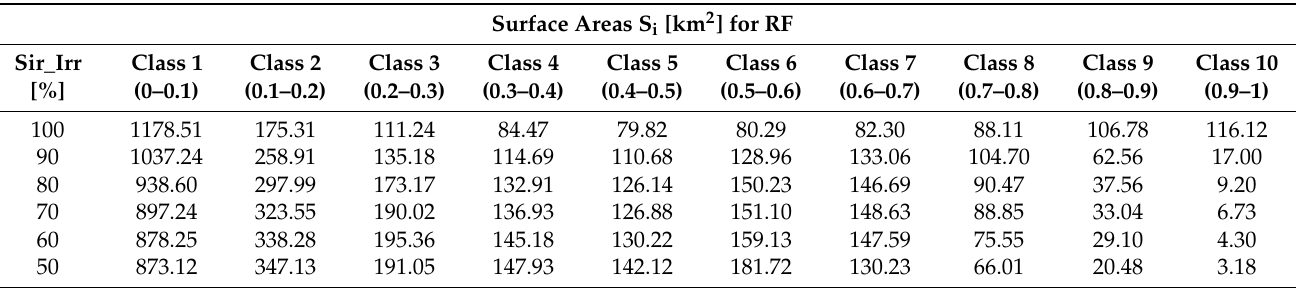
( a ) ( b ) Figure 6. Probability Maps for RF model, reporting a deficit irrigation of 80% ( a ) and 50% ( b ) of the actual value, in the province of Syracuse. Table 5. Values of the surface areas S i (km 2 ) for the deficit irrigation from 100% to 50% of the actual value and the ten classes, for the RF model.